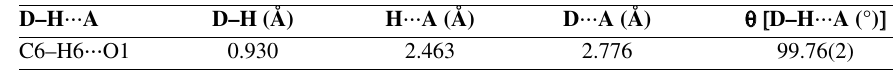
Table 4. The geometry of intramolecular